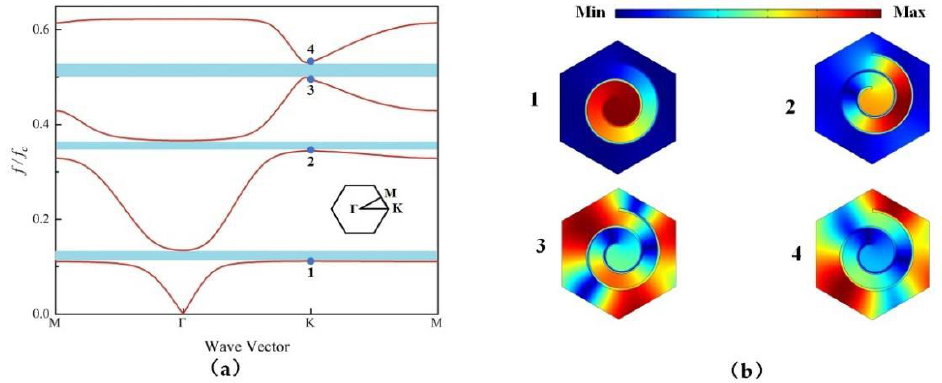
Figure 2. ( a ) The band structure of the left-handed spiral structure with n = 2. ( b ) Eigenmodes at K point in Brillouin zone corresponding to four energy bands.